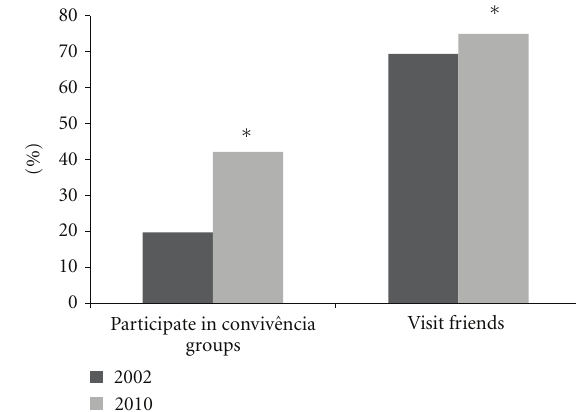
Figure 1: Participation in “convivˆencia” groups and visits to friends between 2002 and